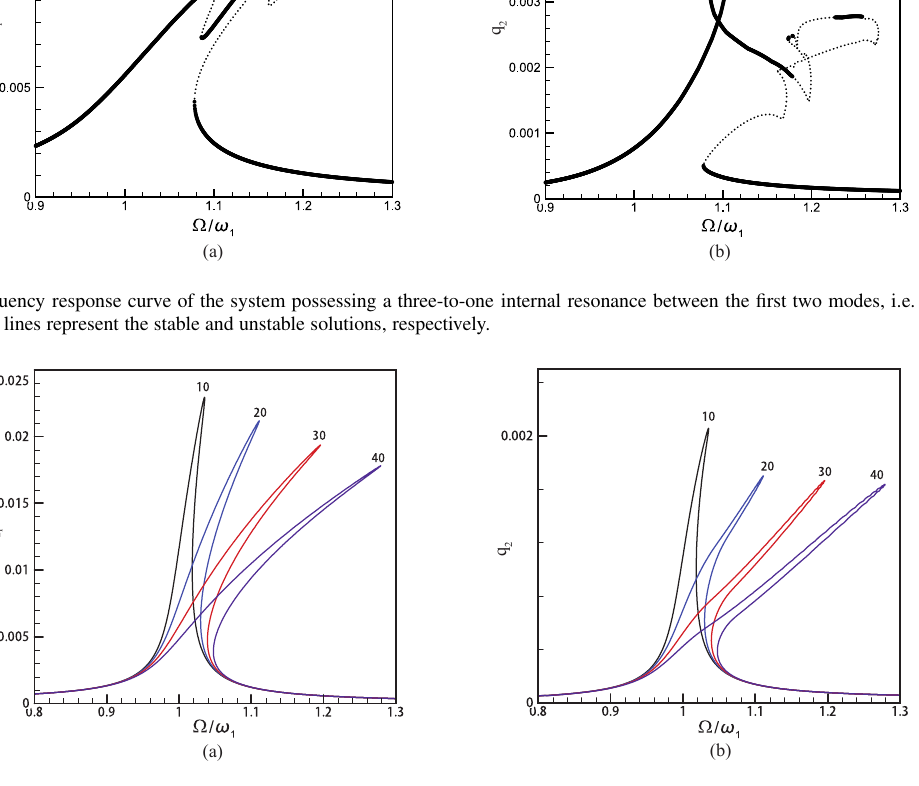
Fig. 4. The frequency response curve of the system with no internal resonances between the first two modes: in the (a) first and (b) second generalized coordinates for several nonlinearity coefficients v 1 . The values of v 1 are denoted on the